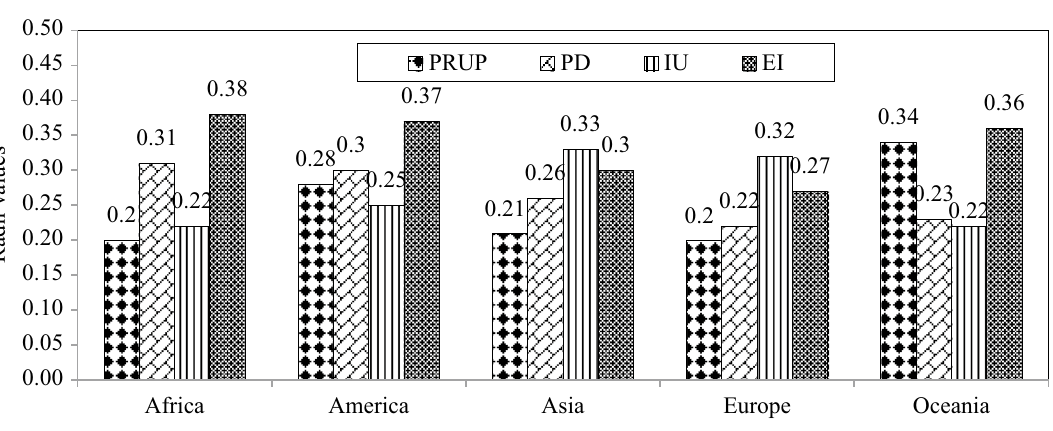
Figure 5. The characteristic of optimal ANFIS-SC model showing the radii